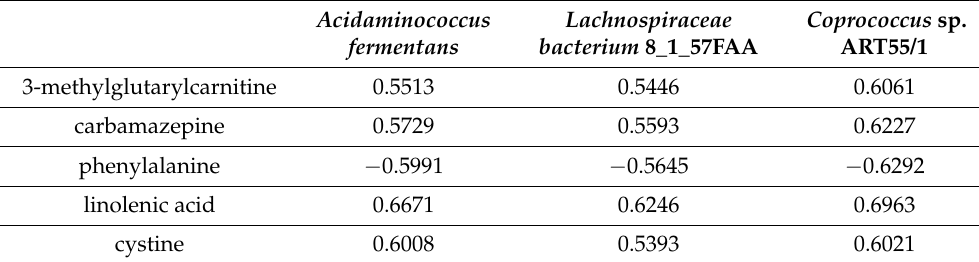
Figure 2. Correlated fecal metabolites and microbial species: ( A ) The overall correlation between fecal metabolites and microbial species is 0.77. ( B ) Similarities (points are clustered) and dissimilarities between samples and groups. Samples are represented as points placed according to their projection in the smaller subspace spanned by microbial species and serum metabolites. ( C ) Agreement between microbial species and fecal metabolites. Each arrow corresponds to one sample. The start of the arrow indicates the location of the sample in the microbial species plot, and the tip is the location of the sample in the fecal metabolites plot. Short arrows indicate if both data sets strongly agree, and long arrows indicate a disagreement between two data sets. ( D ) Correlations between variables of serum metabolites and microbial species. Cut-off is set to 0.6. A black line indicates a negative correlation; an orange line indicates a positive correlation. G1: non-alcoholic control subjects; G2: patients with alcohol-associated non-progressive liver disease; G3: patients with alcohol-associated progressive liver disease. Table 2. Correlation between fecal metabolites and microbial species.